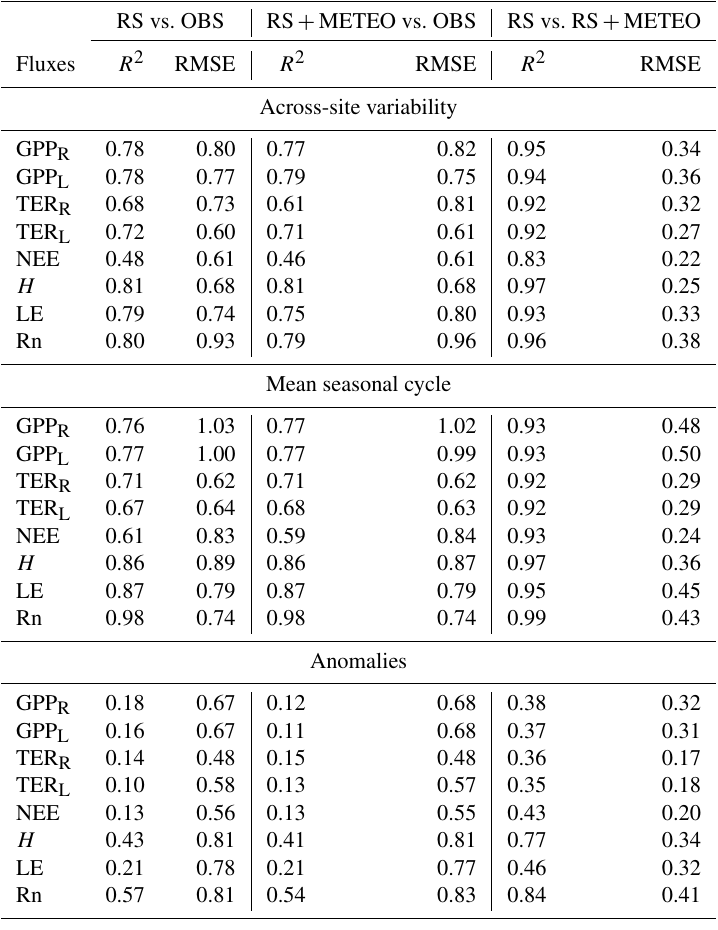
Table 4. R 2 and RMSE for the comparison across sites, mean seasonal cycle and anomalies. The last two columns showed the consistency between the median estimates of the two setups. For RMSE, the reference units were gCm − 2 d − 1 and MJm − 2 d − 1 for CO 2 fluxes (GPP, TER and NEE) and energy fluxes ( H , LE and Rn),